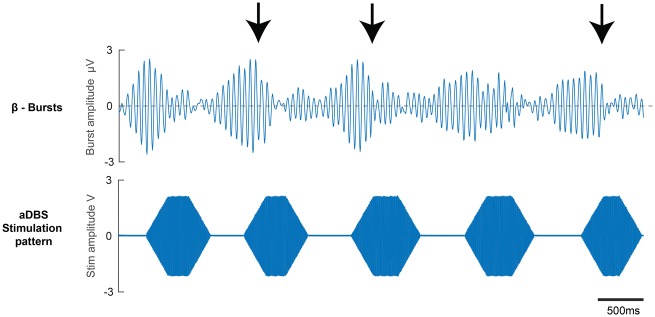
Burst trimming effects of adaptive DBS illustrated on a series of beta bursts. Subject 11, left side. The top row shows a consecutive sequence of beta bursts observed during adaptive DBS. The bottom row shows the stimulation pattern as induced by the corresponding bursts above. Bursts appear terminated by the triggered stimulation and bursts with black arrows do end relatively abruptly, coinciding with the ramp-up of stimulation. aDBS = adaptive DBS.